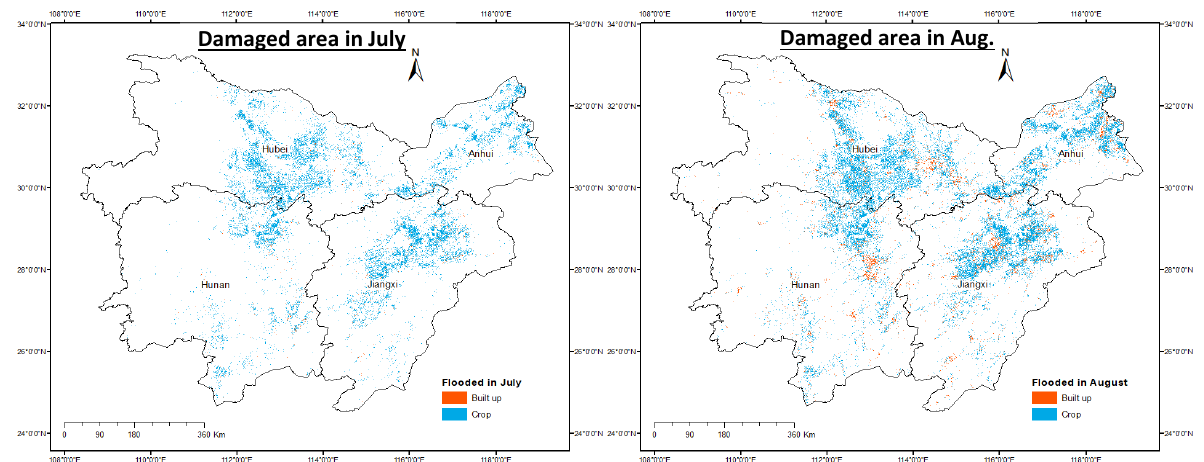
Figure 11. Damaged cropland area map in July and August 2020.